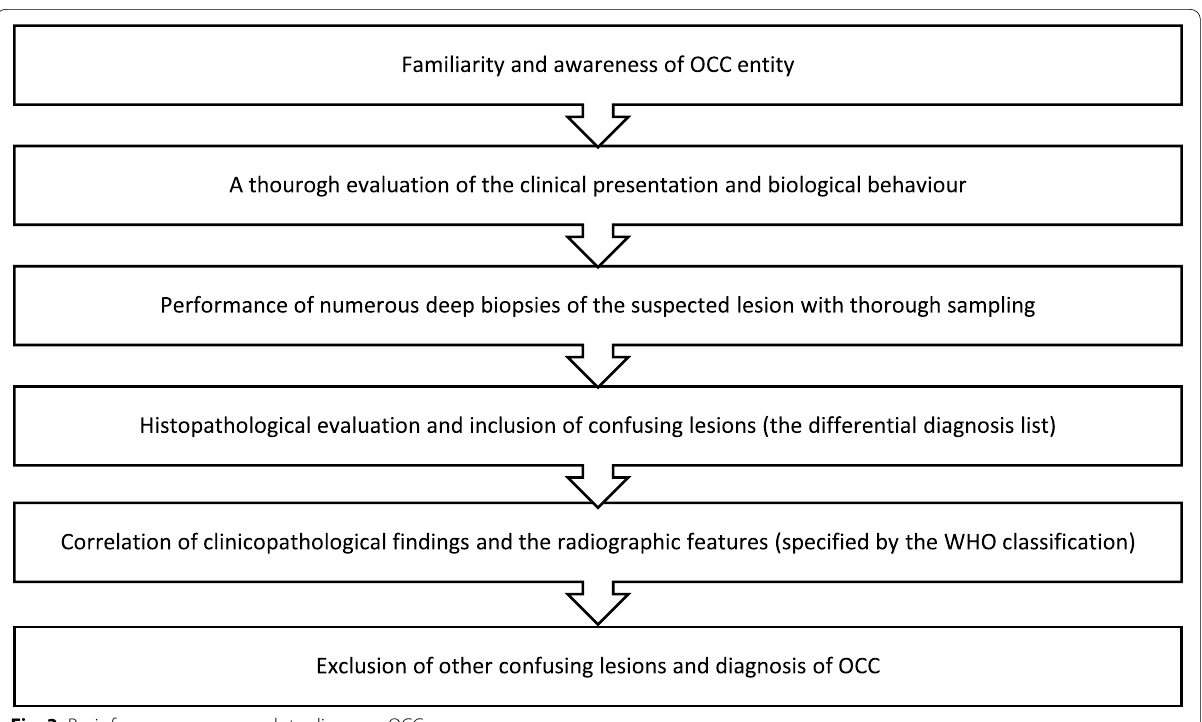
Fig. 3 Basis for a proper approach to diagnose